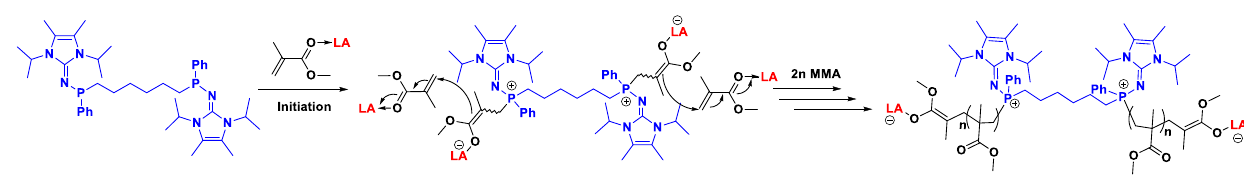
Fig. 6 Mechanism. Proposed mechanism for polymerization via dual initiation by µ Hex [P(NI i Pr)Ph] 2 -based LP.